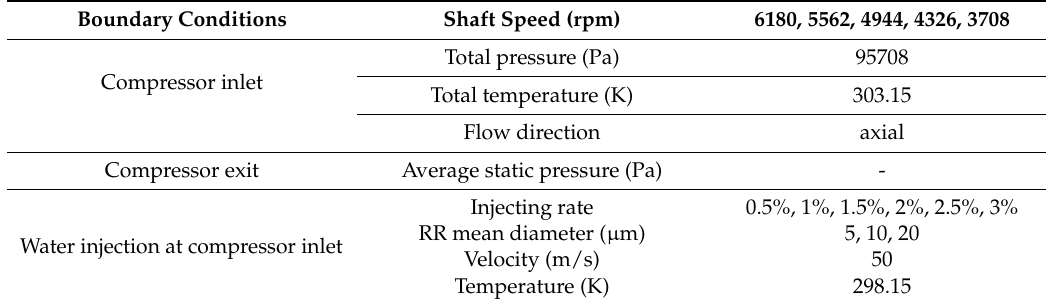
Table 2. Parameter settings of boundary conditions for the multistage axial compressor.